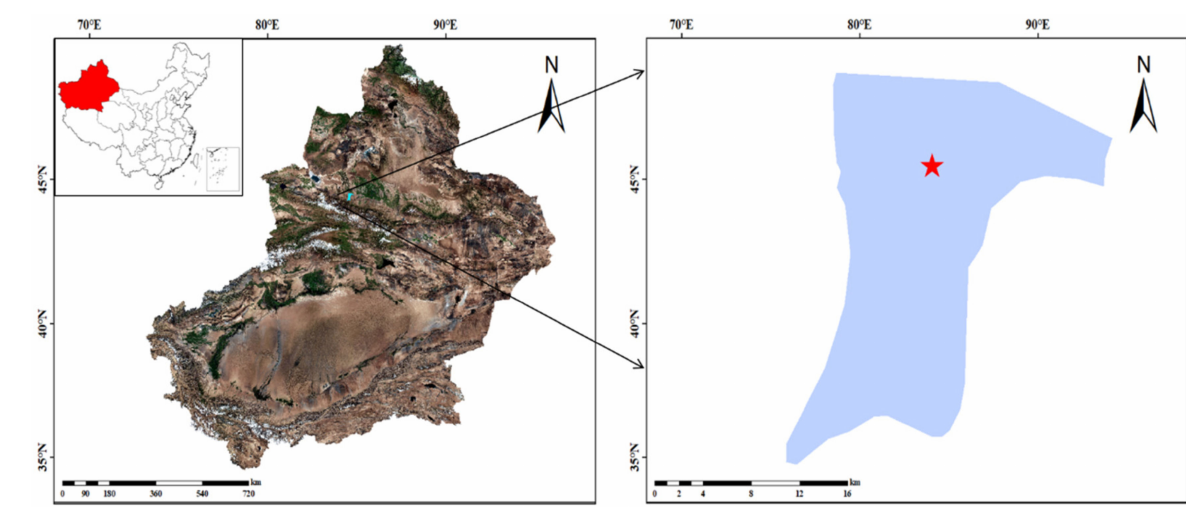
Figure 1. Location of the sampling